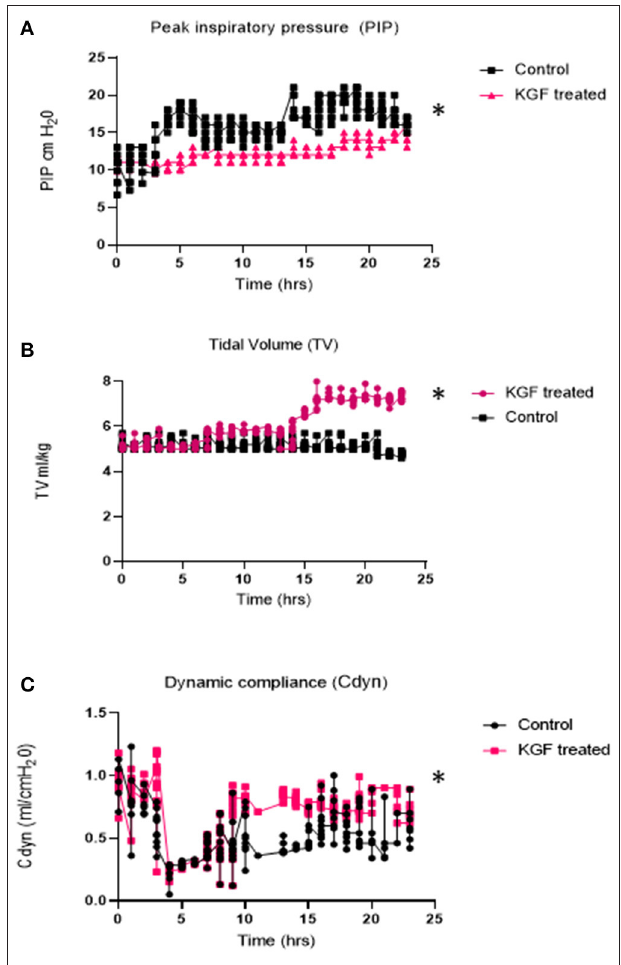
FIGURE 2 | Physiologic parameters measured during 24 hr. of mechanical ventilation in KGF treated pigs ( n = 6), control pigs ( n = 6) (A) Peak Inspiratory Pressures (PIP -cm H 2 0) was significantly lower in KGF treated animals (* p < 0.05); (B) Tidal volumes (ml/kg) were significantly higher in the KGF treated animals (* p < 0.05); (C) Dynamic lung compliance (ml/cmH 2 0) was higher in KGF treated animals (* p <